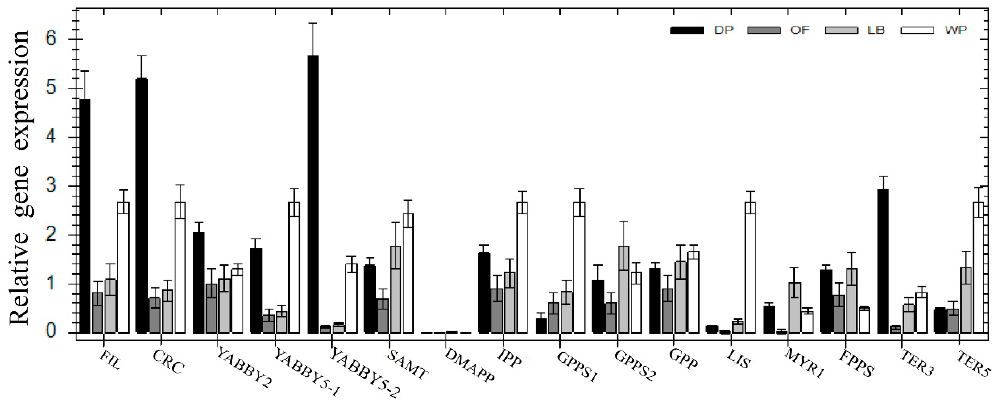
Figure 5. Quantitative real-time PCR analysis of different genes in four different developmental stages of DP, OF, LB, and WP. Tublin homologous gene of Chimonanthus praecox was used as an internal control.